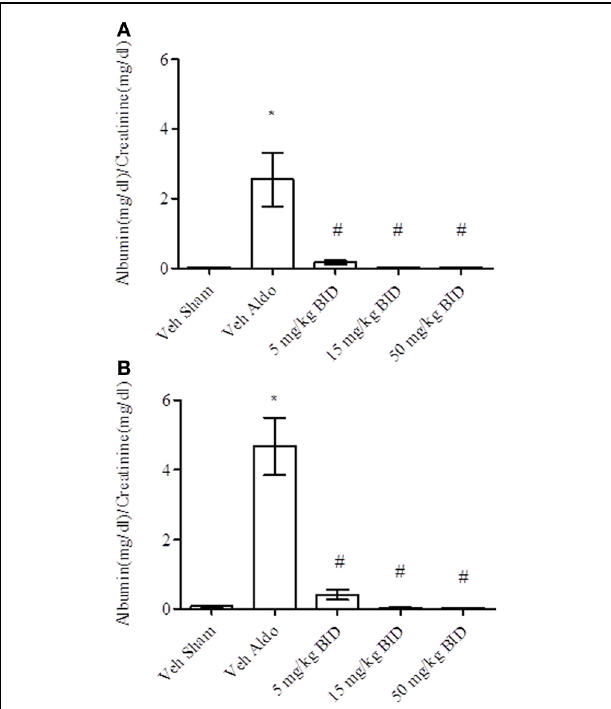
FIGURE 2 | Effect of PF-03882845 on UACR on day 14 (A) and day 26 (B). Data are represented as mean ± standard error of the mean. See Materials and Methods for statistical analysis. ∗ Indicates a significant difference from the vehicle sham (Veh Sham) group; # Indicates a significant difference from the vehicle + aldosterone (Veh Aldo) group.